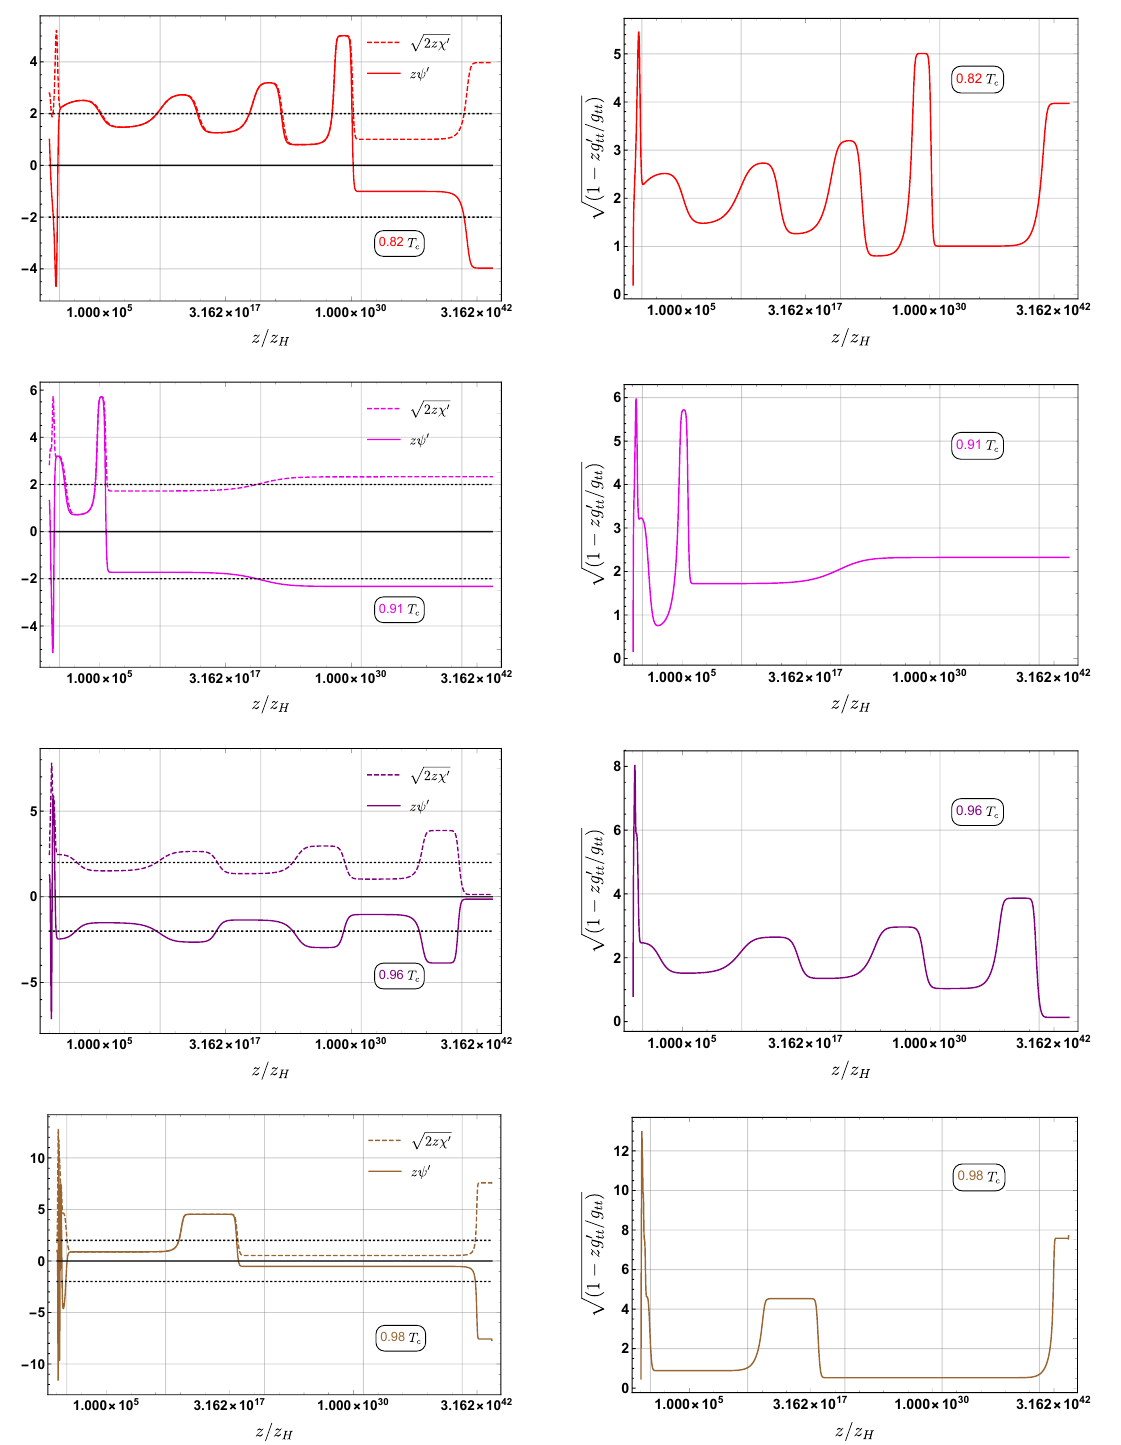
√ 2 zχ 0 (left) and p 1 − zg 0 /g tt (right) inside the su- tt = 0 . 82 , 0 . 91 , 0 . 96 and 0 . 98 , c